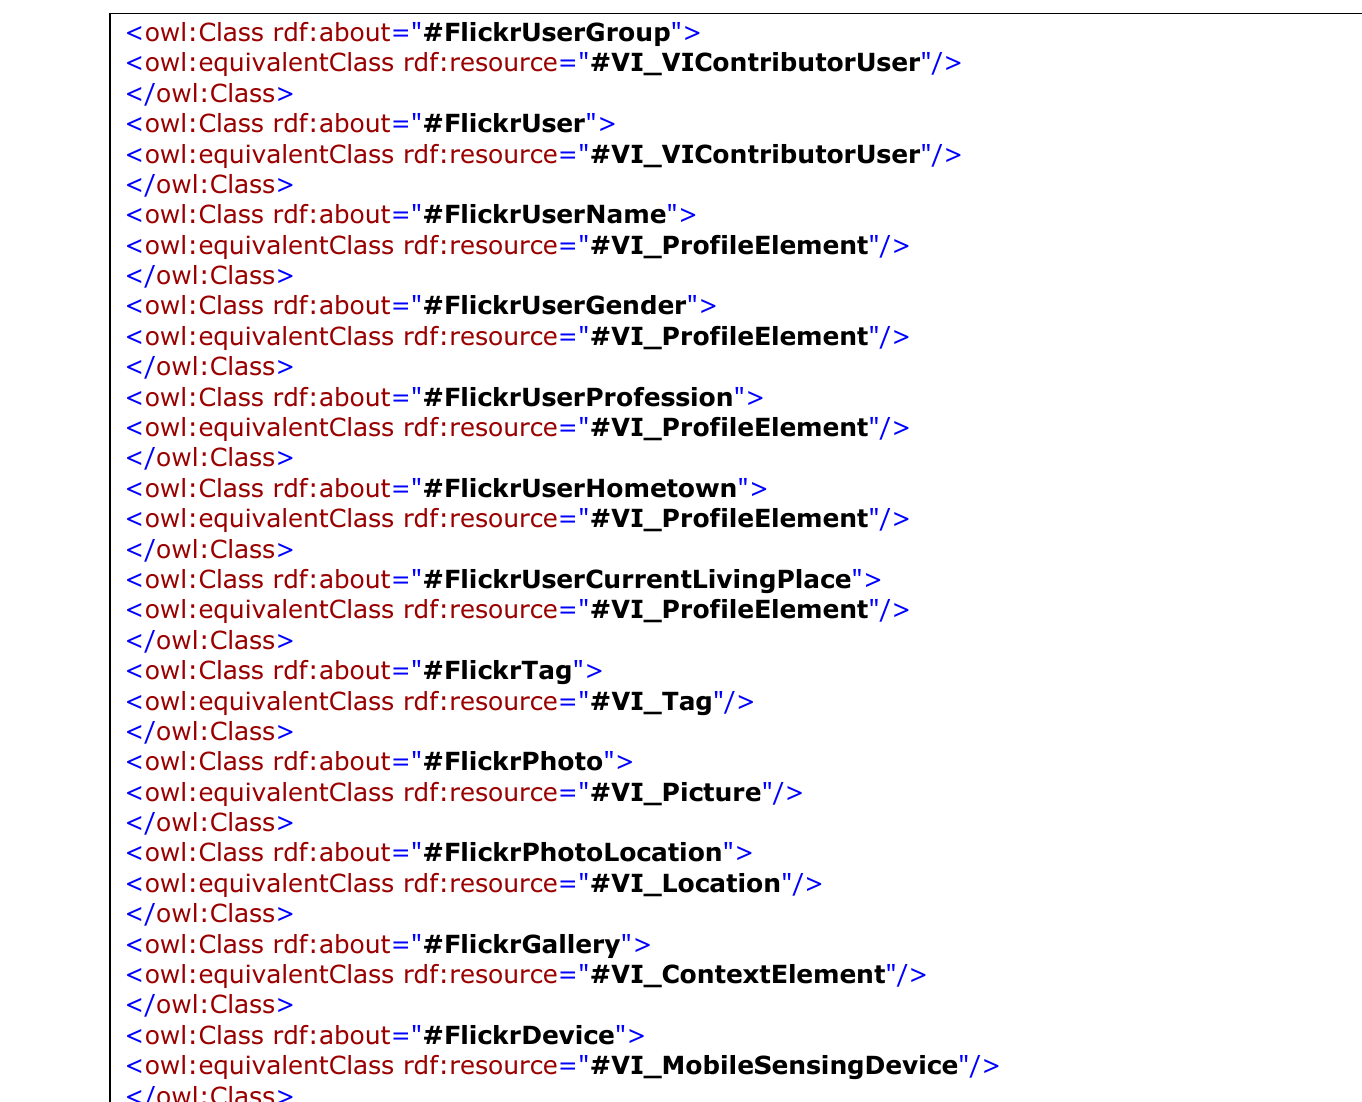
Figure 8. Mappings between Flickr and the VGI Semantic